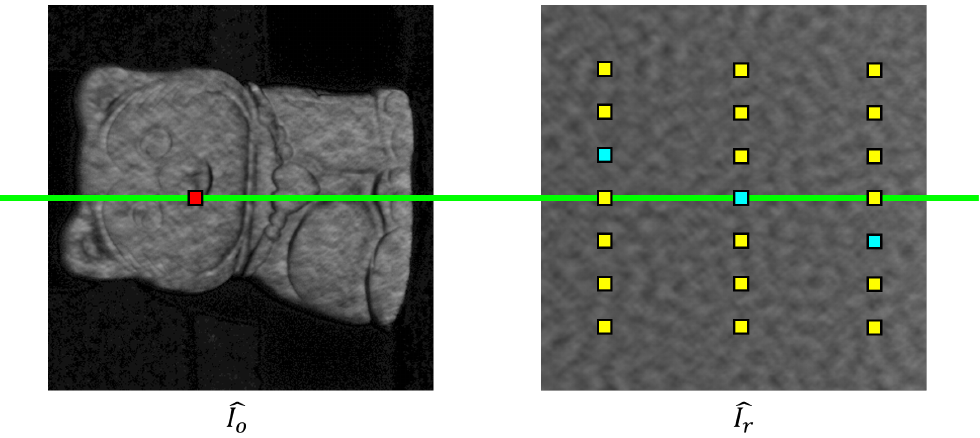
Figure 2. The schematic process of generating candidate corresponding points for the SGM algorithm. (Red point: POI, yellow points: offset pixels from epipolar points with wrapped phase constraint, light blue points: offset pixels with the smallest C ZNSSD on their column, green line: pre-computed epipolar line through absolute phase constraints).